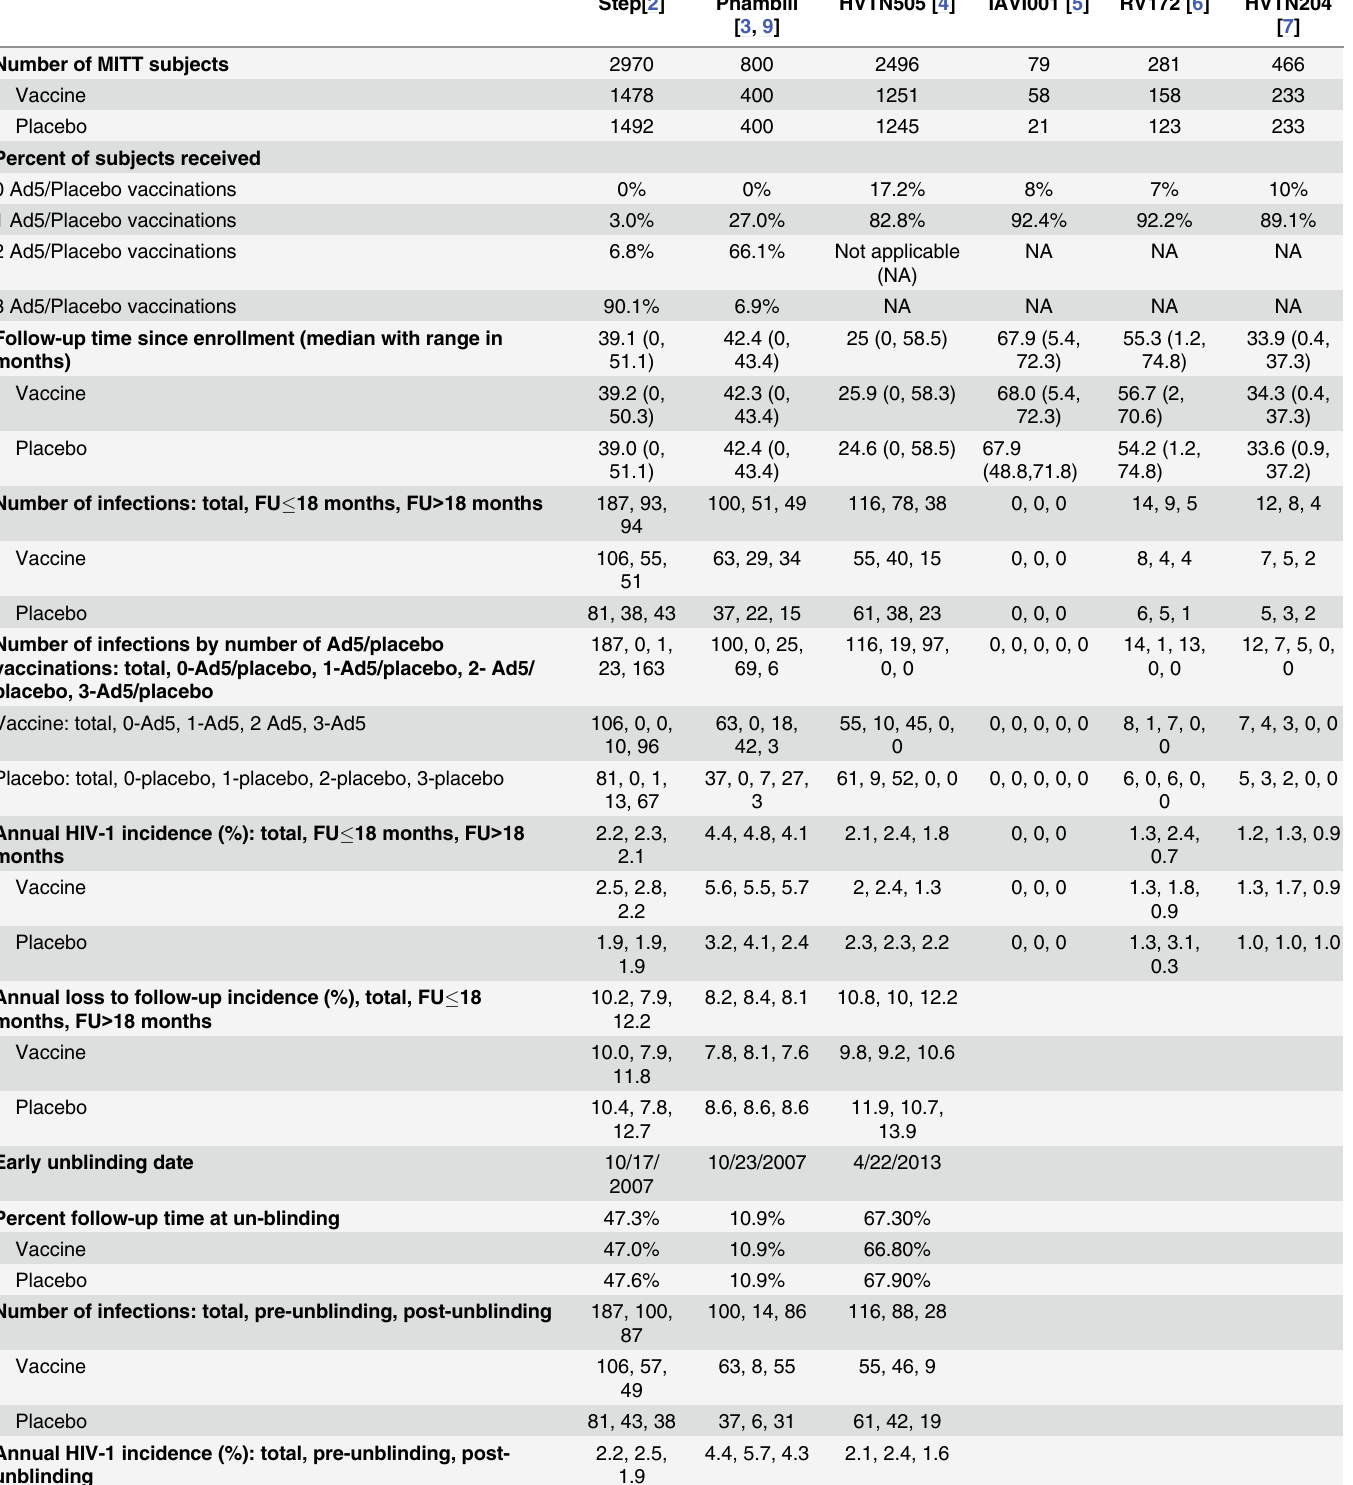
Table 2. Key Data Summary of Individual Studies Included in the